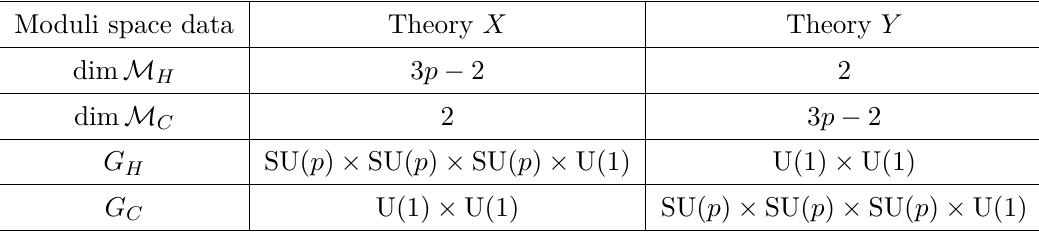
Table 10 . Summary table for the moduli space dimensions and global symmetries for the mirror pair in figure 34.